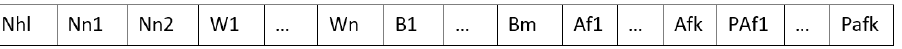
Figure 2. Structure of the genotype representing the evolved ANN parameters.